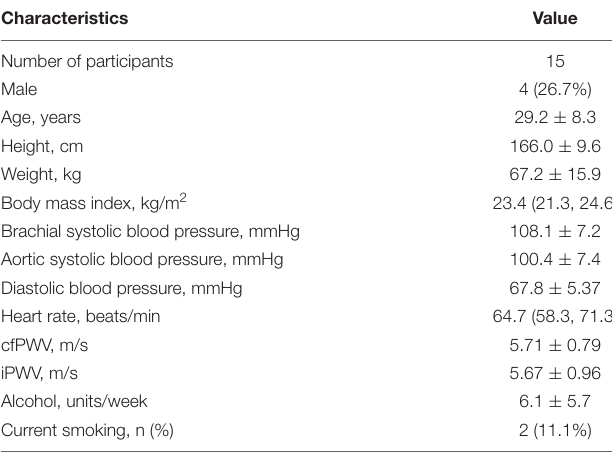
TABLE 1 | Participant characteristics at recruitment,